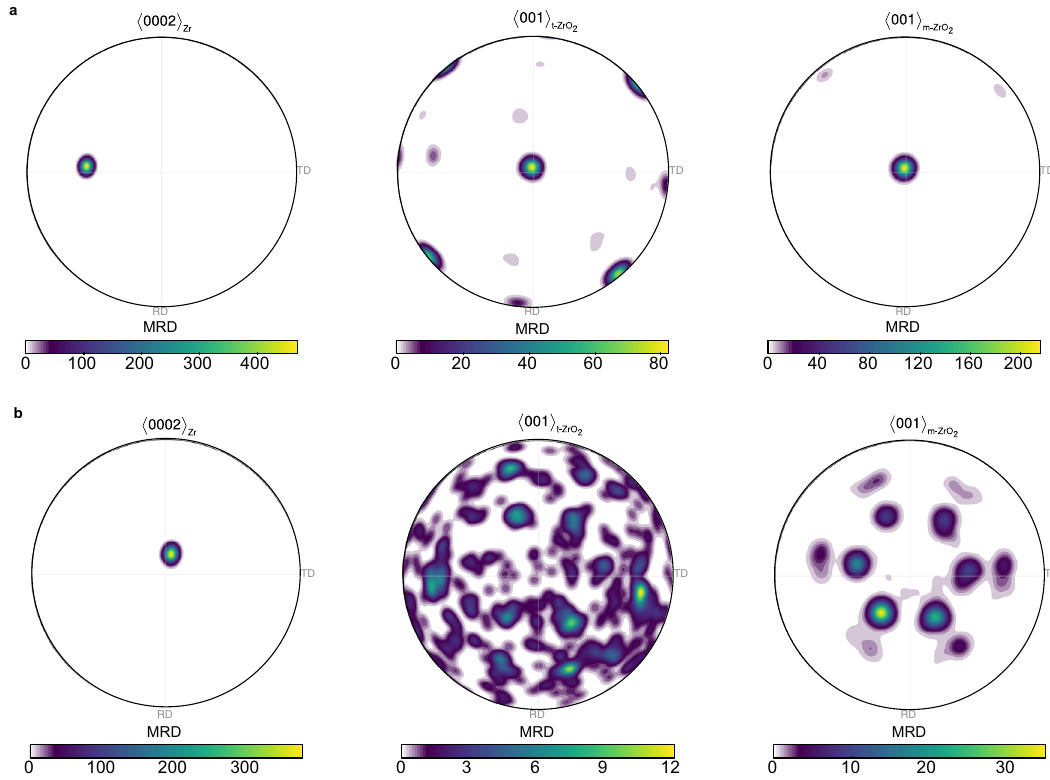
Fig.2|Electronbackscatterdiffractioncontouredpole fi gures. Contouredpole fi guresforthe<0002> poleinhexagonalZr,andthe<001>polesintetragonaland monoclinic ZrO 2 in a metal grain 1 and oxide region 1; b metal grain 2 and oxide region 2. All contoured pole fi gures are normalised to multiples of a random